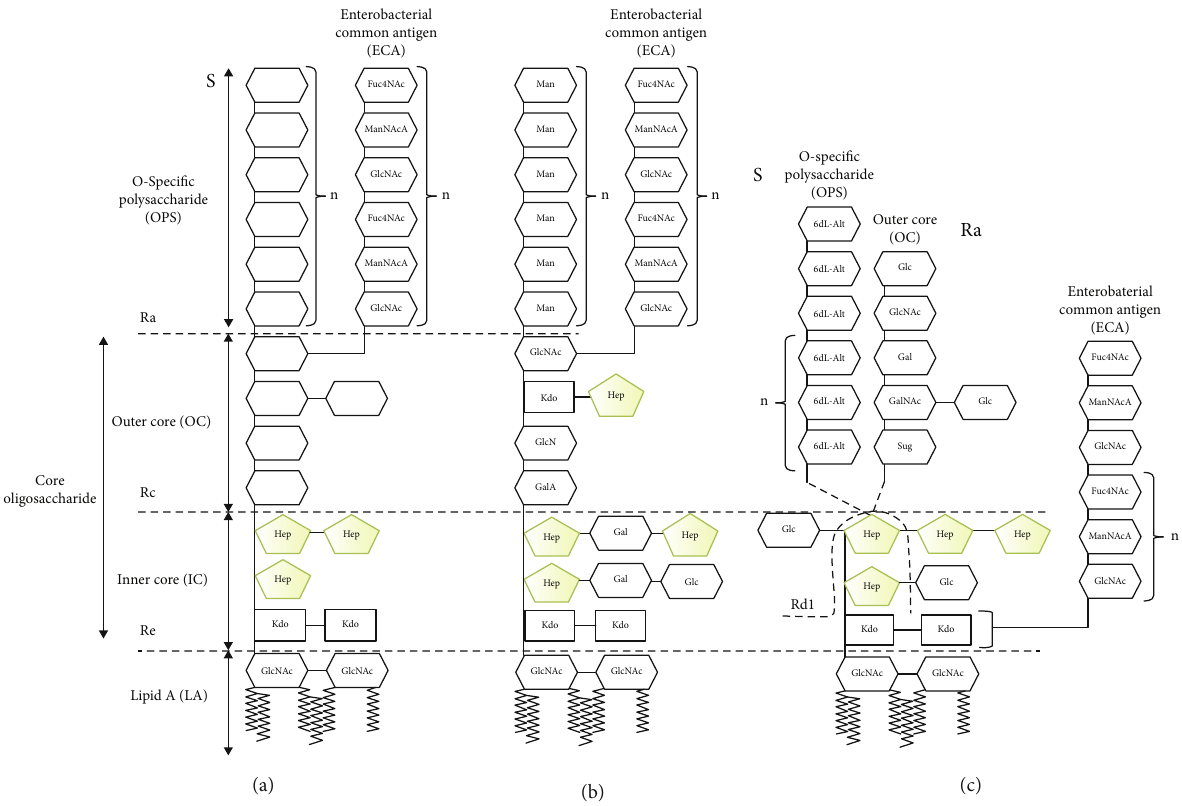
Figure 1: Schematic structures of K . pneumoniae O:3 and Y . enterocolitica O:3 LPS. (a) LPS typical for majority of Enterobacteriaceae . The empty hexagons re fl ect the sugar residue variability in the outer core oligosaccharide (OC) and O-speci fi c polysaccharide (OPS) structures of di ff erent strains. The zigzag lines in LA represent fatty acids. (b) Schematic structure of K . pneumoniae O:3 LPS. (c) Schematic structures of Y . enterocolitica serotype O:3 strain and its mutants used in this work. The chemotypes of the YeO:3 LPS molecules are indicated by letter abbreviations and the dashed lines indicate the point(s) of truncations: S: LA-IC-OPS; Ra: LA-IC-OC; Rd1: LA-Kdo-Hep; Re: LA-Kdo. The wild-type O:3 bacteria produce a mixture of S- and Ra-type LPS molecules. The sugar residues: 6dL-Alt: 6-deoxy- L -altropyranose; Hep: D -glycero- D -manno-heptopyranose; Fuc4NAc: N -acetyl- D -fucos-4-amine (4-acetamido-4,6-dideoxy- D -galactopyranose); GalNAc: N - acetyl- D -galactosamine (2-acetamido-2-deoxy- D -galactopyranose); Glc: D -glucopyranose; GlcNAc: N -acetyl- D -glucosamine (2-acetamido-